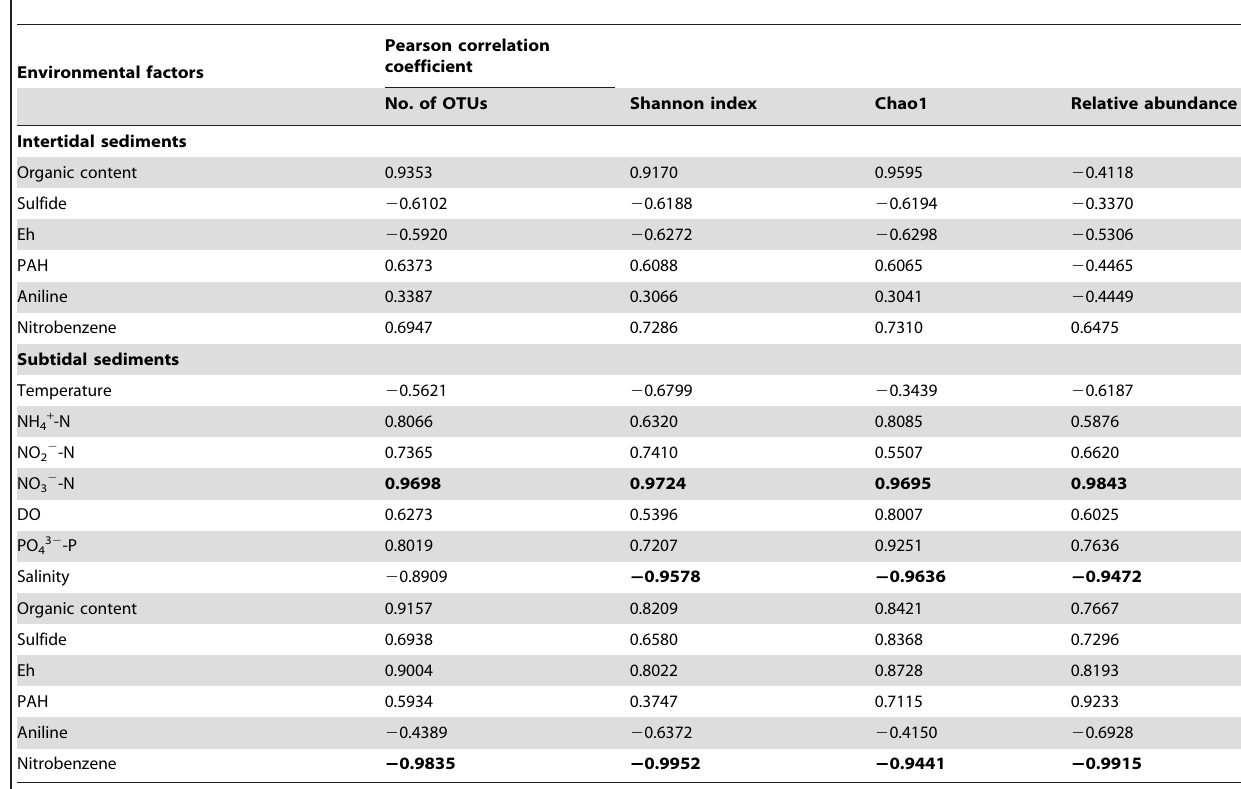
Table 6. Correlation analysis of environmental factors and anammox bacterial diversity and abundance within the Jiaojiang Estuary.